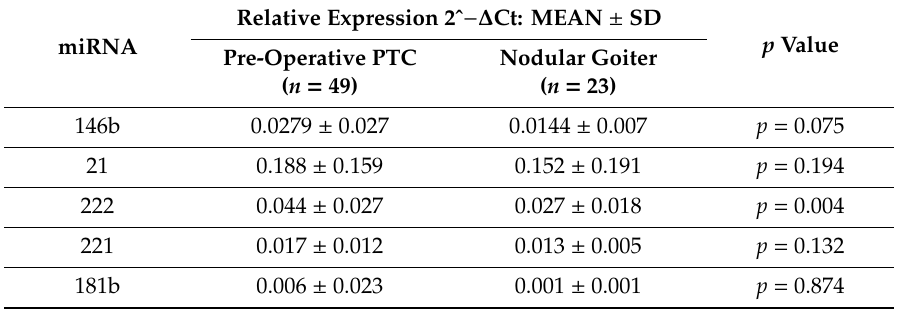
Table A2. miRNA expression comparison between PTC patients before surgery and NG patients’ plasma